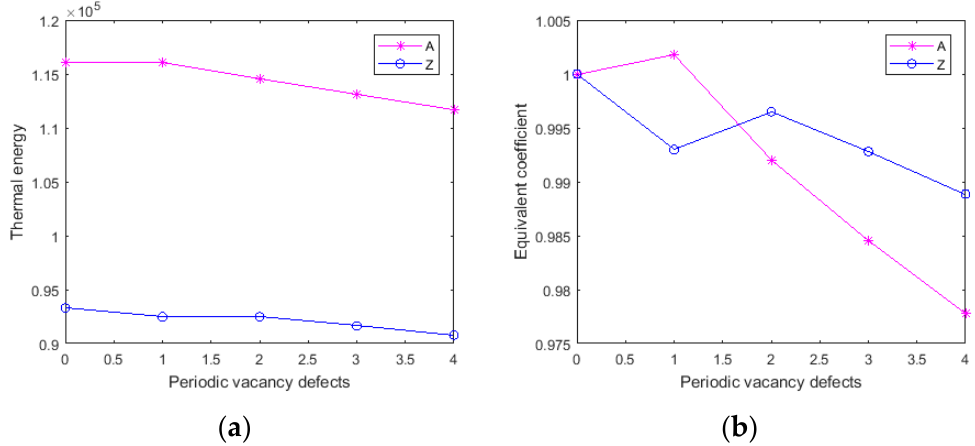
Figure 10. The results of graphene with periodic vacancy defects. A—heat source in armchair edge, Z—heat source in zigzag edge. And ( a ) is for the thermal energy, ( b ) is for the equivalent coefficient, unit for thermal energy is J.